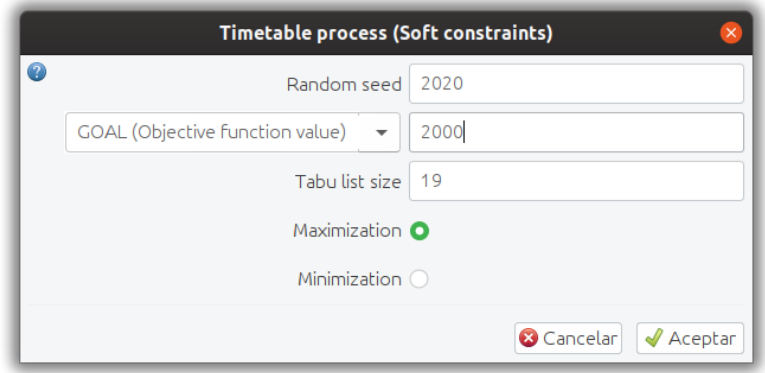
Figure 14. Sample configuration of the TS-PAC parameters for the TTP phase (soft constraints).